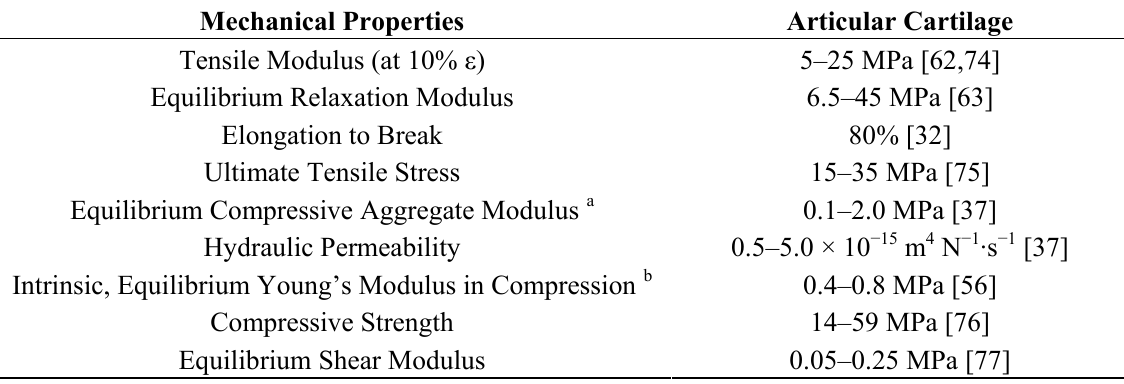
Table 2. Mechanical properties of articular cartilage tissue (regardless of